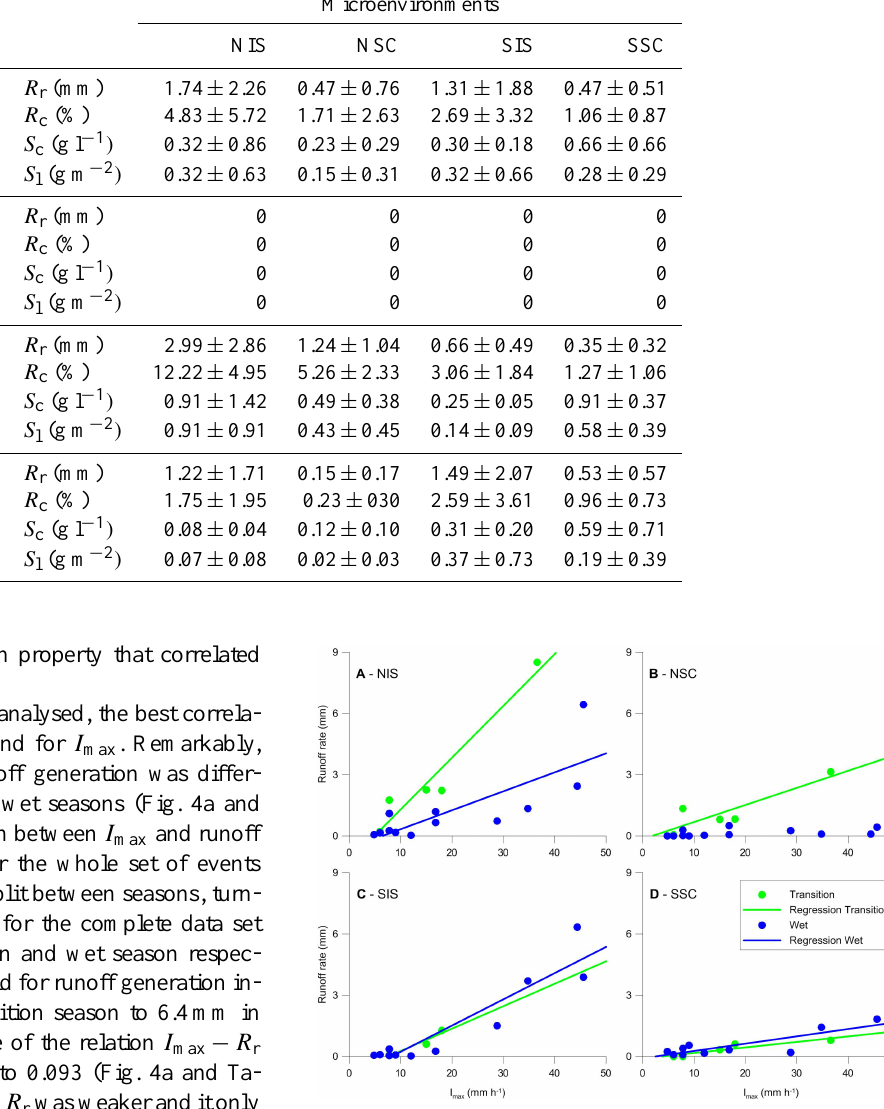
Fig. 4. Relation between I max and runoff rate in every microenvi- ronment. NIS: north-facing inter-shrub; NSC: north-facing shrub- covered; SIS: south-facing inter-shrub; SSC: south-facing shrub-